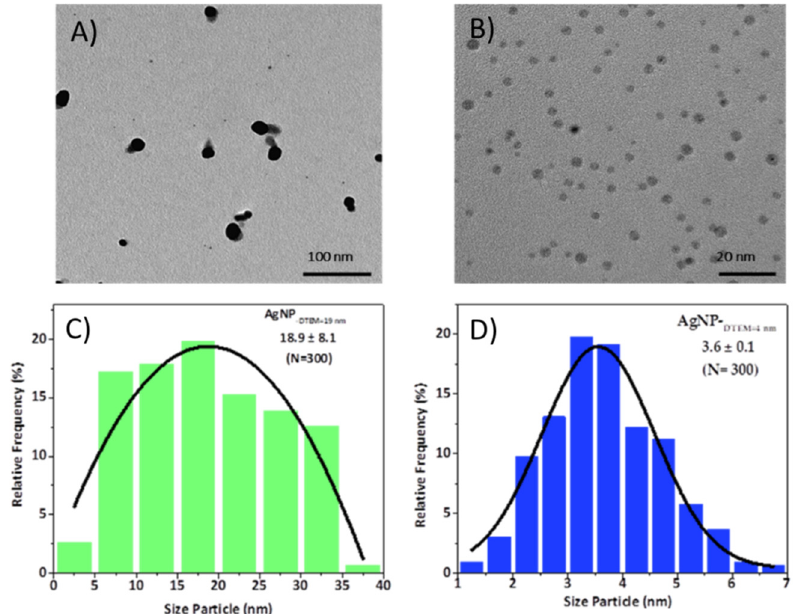
Figure 5. TEM micrographs and size distribution histograms of the PEI-coated, PVP-stabilized AgNP: 19 nm ( a ), ( c ) and 4 nm ( b ), ( d ). Size distribution was performed using Image J software (https://imagej.nih.gov/ij/download.html).